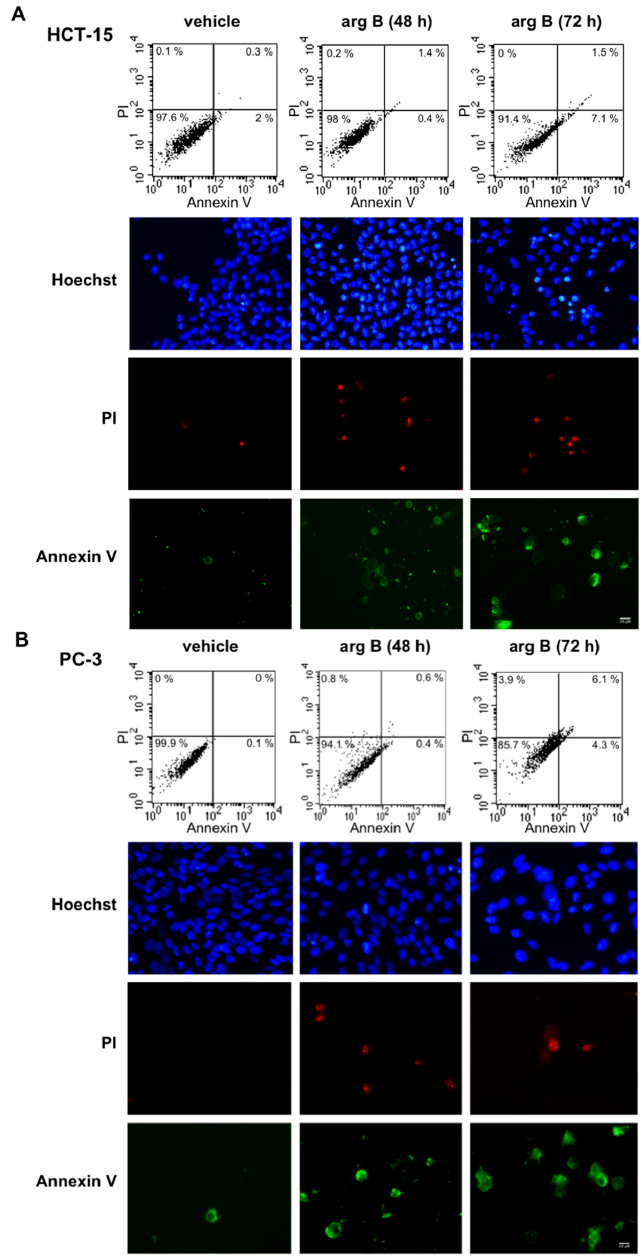
Figure 3. Effect of argentatin B on cell death. HCT-15 ( A ); and PC-3 ( B ) cells were incubated with argentatin B (arg B) for 48 h and 72 h. Cell death was analyzed by labelling with Annexin V and Propidum Iodide (PI). The number of apoptotic and necrotic cells was evaluated by flow cytometry (upper panel). The proportion of viable cells, showing negative annexin and PI staining is depicted in the left lower quadrant. Apoptotic cells, positive annexin, are shown in the right lower quadrant. Necrotic cells, positive annexin and PI staining, are presented in the right upper quadrant. Results are representative figures from three independent tests. Cells stained with Annexin, PI, and Hoechst were also analyzed by fluorescence microscopy (lower panel). Figures are representative micrographs from three independent experiments.